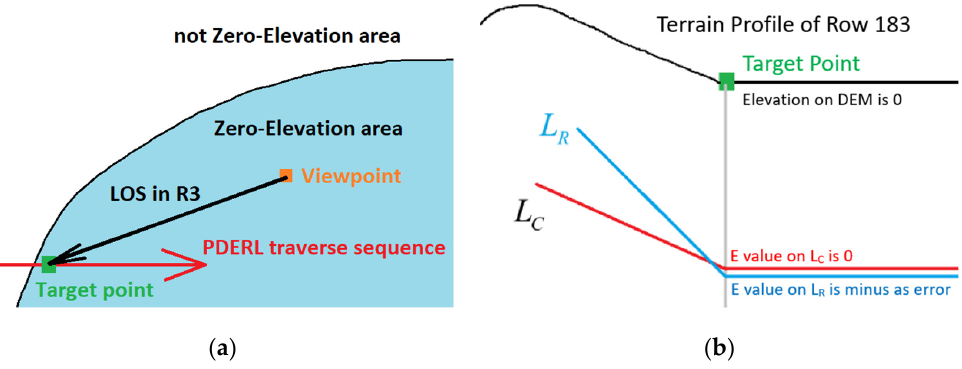
Figure 10. Reasons for the problem shown in Figure 9. ( a ) The DEM demonstration around the viewpoint at row 183, column 185; ( b ) The terrain profile of row 183. To calculate the visibility of the target point (marked with green in both figures), the PDERL algorithm must traverse almost the whole of row